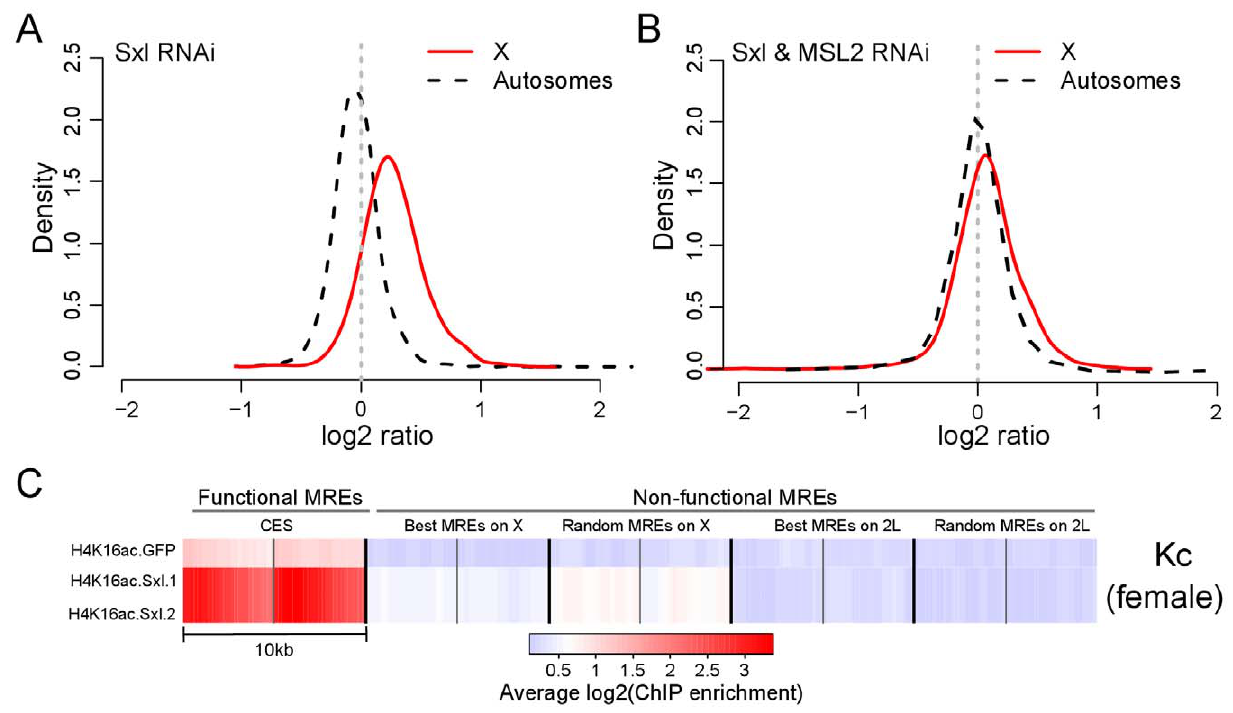
Figure 2. Ectopic upregulation of MSL2 by Sxl RNAi treatment induces dosage compensation of X-linked genes in female Kc cells by preferentially targeting MREs in an active chromatin context. (A) Distribution of gene expression ratios after Sxl knockdown in X chromosome and autosomes compared to control. The y -axis (density) represents the scaled proportion of the number of genes for a given log2 expression ratio ( x -axis). Repression of Sxl leads to ectopic expression of MSL2, which results in dosage compensation of the X chromosome. (B) Distribution of gene expression ratios after Sxl and MSL2 double knockdown for X chromosome and autosomes compared to control. In the absence of functional MSL2, no dosage compensation is observed. (C) A heat map showing the average enrichment of H4K16 acetylation (H4K16ac) around ( + / 2 5 kb) the functional and non-functional MREs in control (GFP) and after two independent Sxl RNAi knockdowns. The gene expression data in panels A and B are based on the same cells as replicate 1 in the heat